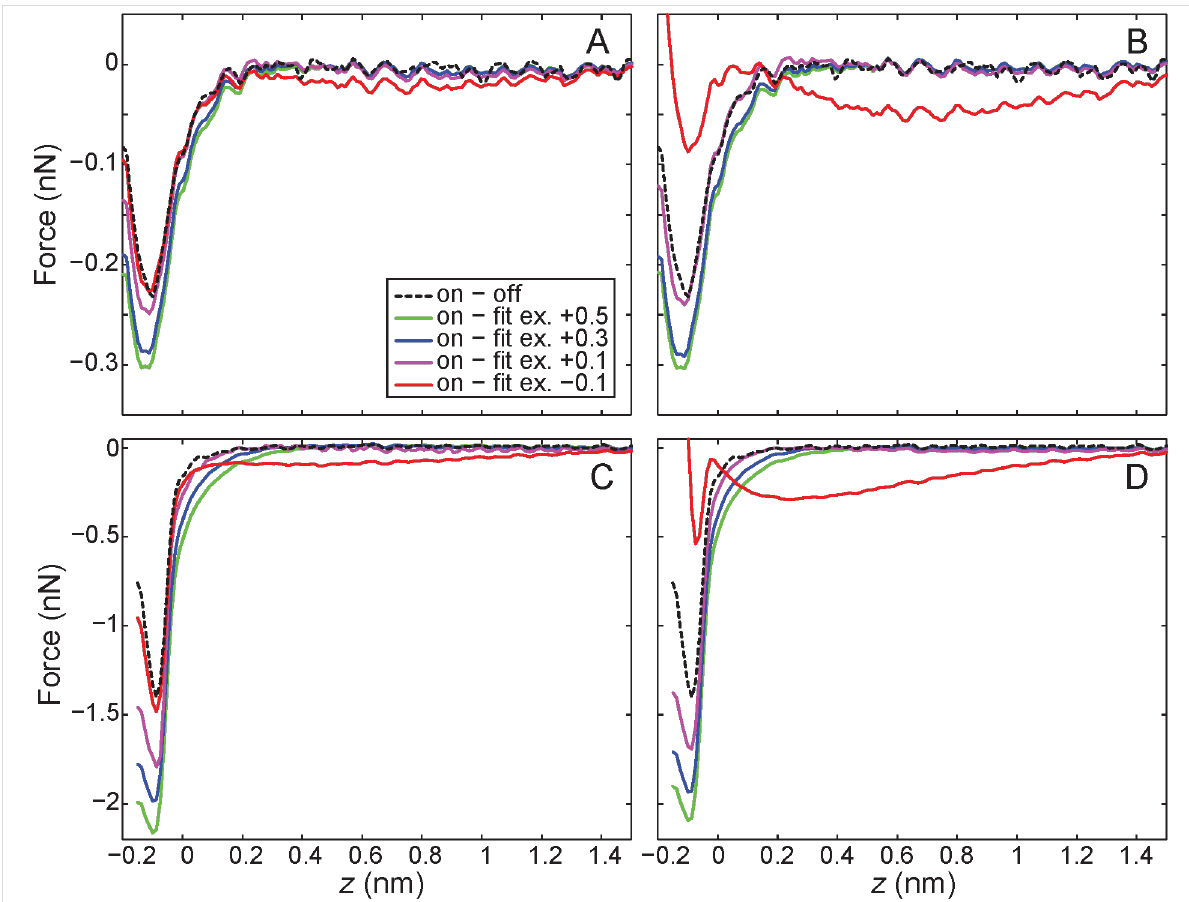
Figure 2: Extracted short-range force curves from ‘on-minus-off’ extraction, and comparison to long-range fitting for A) Tip–C 60 interaction fitting to ‘off’ curve, B) Tip–C 60 interaction fitting to ‘on’ curve, C) Tip–Si interaction fitting to ‘off’ curve, D) Tip–Si interaction fitting to ‘on’ curve. In the legend ‘ex’ indicates the point below which data was excluded from the fitting (e.g., ex = +0.1 indicates any data below +0.1 nm was excluded from the